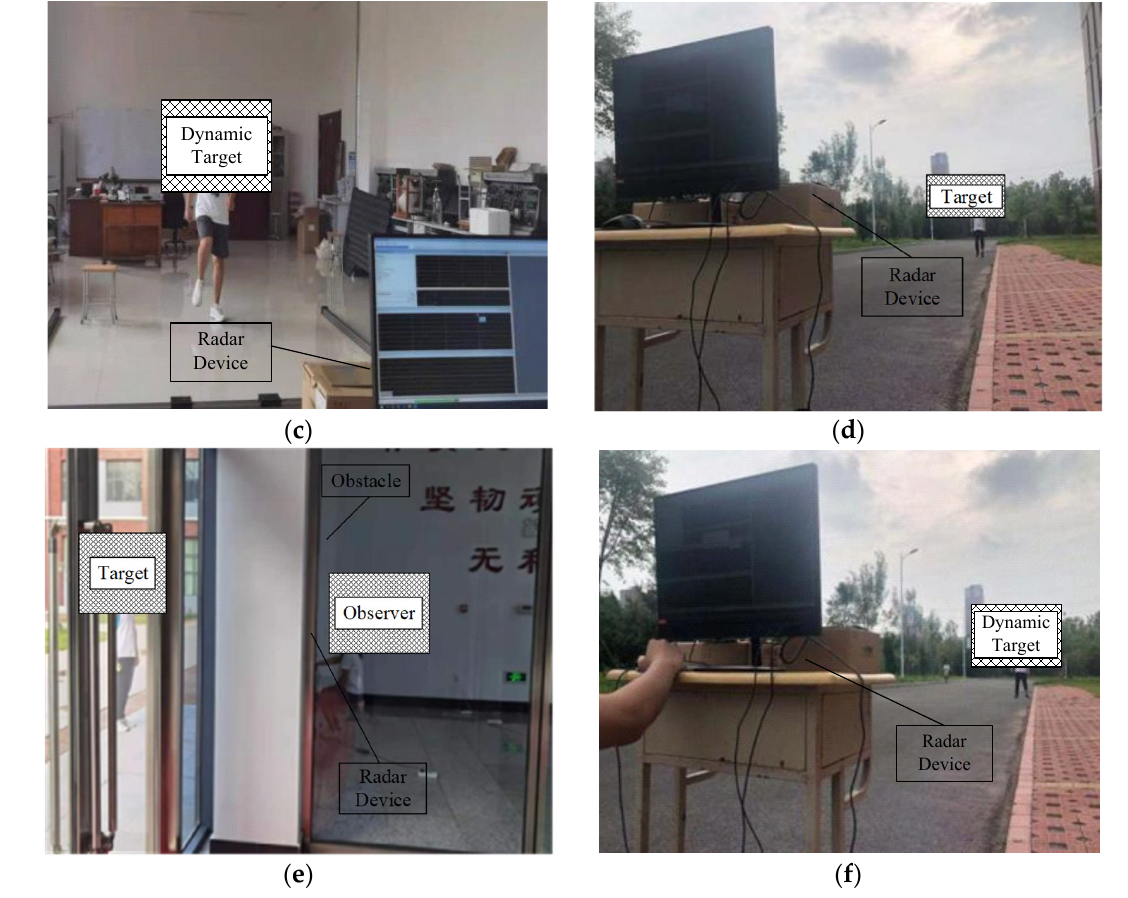
Figure 3. Experimental setup of the system for different scenes: ( a ) Detection of indoor stationary target; ( b ) Detection of indoor stationary target covered by obstacle; ( c ) Detection of indoor dynamic target; ( d ) Detection of outdoor stationary target; ( e ) Detection of outdoor stationary target covered by obstacle; ( f ) Detection of outdoor dynamic target.